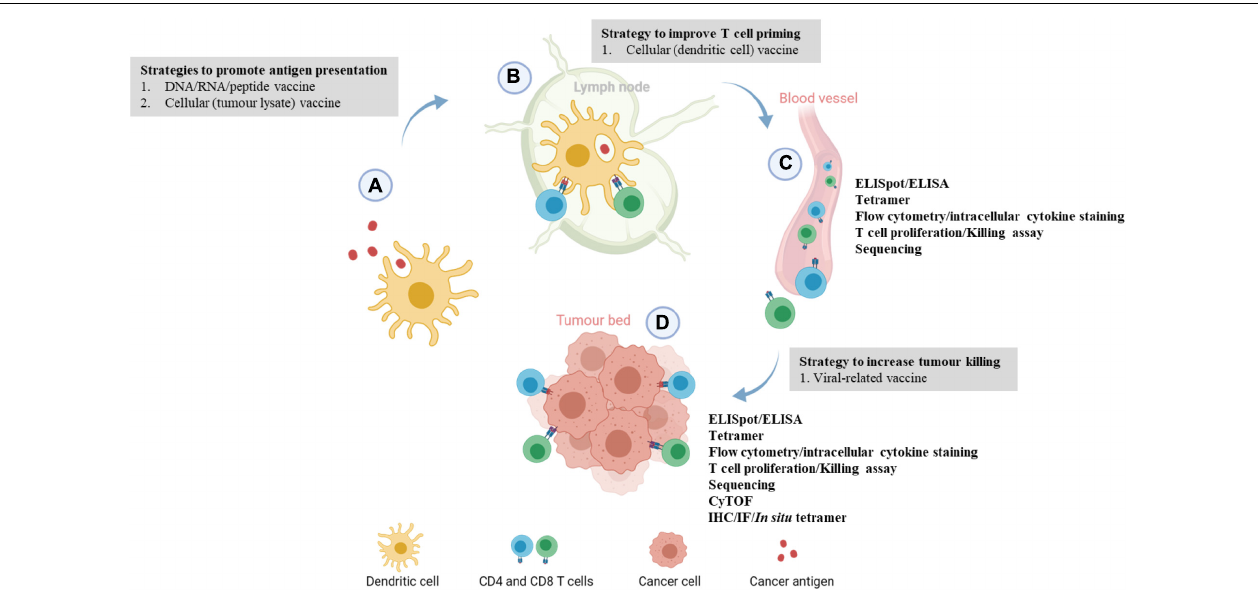
FIGURE 1 | Immune monitoring of cancer vaccination at different phases of the cancer immunity cycle. (A) Upon vaccination, peptides or cancer antigens are digested and internalized by antigen-presenting cells, usually dendritic cells (DCs). (B) Antigen-presenting DCs travel to the lymph nodes to prime and activate naïve T cells through T cell receptor signaling and co-stimulation. (C) Upon activation, antigen-specific CD4 or CD8 T cells circulate through the blood to locate the tumor, this juncture allows the development of ex vivo immunoassays where antigen-specific T cells can be detected. Blood/peripheral blood mononuclear cell from cancer patients are usually harvested and antigen-specific immune responses are evaluated by ELISpot, T cell proliferation, killing assay, intracellular cytokine staining, and flow cytometry phenotyping. (D) At the tumor bed, activated immune cells will bind to tumor cells expressing the target of interest and induces cell lysis. Localization and levels of infiltrating antigen-specific T cells can be examined through multiplexed IHC/IF and ELISpot assay. More recently, tumor-infiltrating lymphocytes from patients’ tumors are extracted to evaluate the phenotypic changes or functions of the immune cells via RNA sequencing or scRNA sequencing. This image was created with